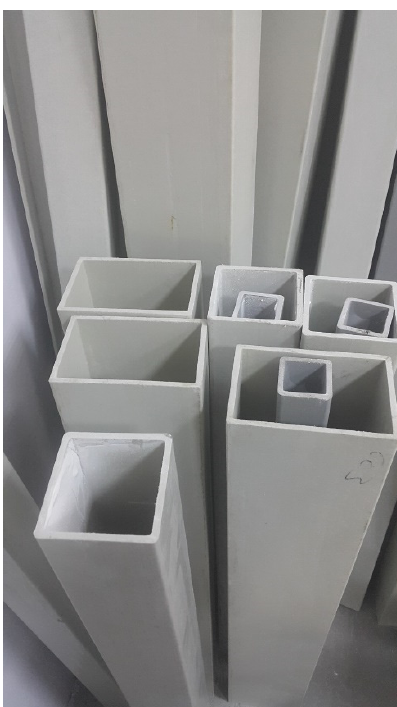
Figure 1. Pultruded GFRP profiles.